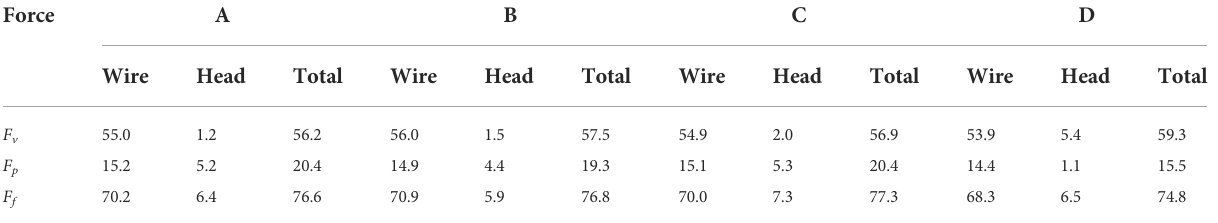
TABLE 3 Viscous drag, pressure drag and fl ow resistance for four fi lters with different heads (unit: dyne). Force